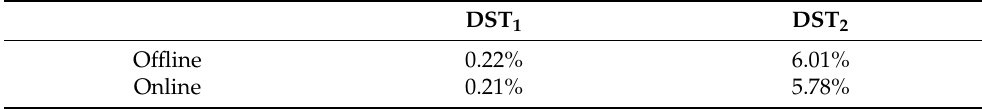
Table 6. Comparison of the predictive errors between offline mode and online